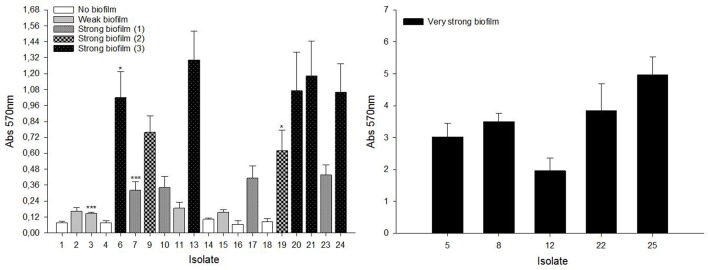
Biofilm-forming capacity of staphylococcal clinical isolates. 96-well flat-bottom polystyrene plates were incubated for 24 h at 37°C without shaking. Cells attached to the wells were stained with 0.1% (w/v) crystal violet. Absorption at 570 nm was measured to quantify biofilm formation. Results are the mean ± SEM of at least 4 independent biological experiments performed in triplicate. To classify the isolates into significant groups, statistical analysis was performed using Student's t-test or Mann–Whitney U-test (*p < 0.05, ***p < 0.001).